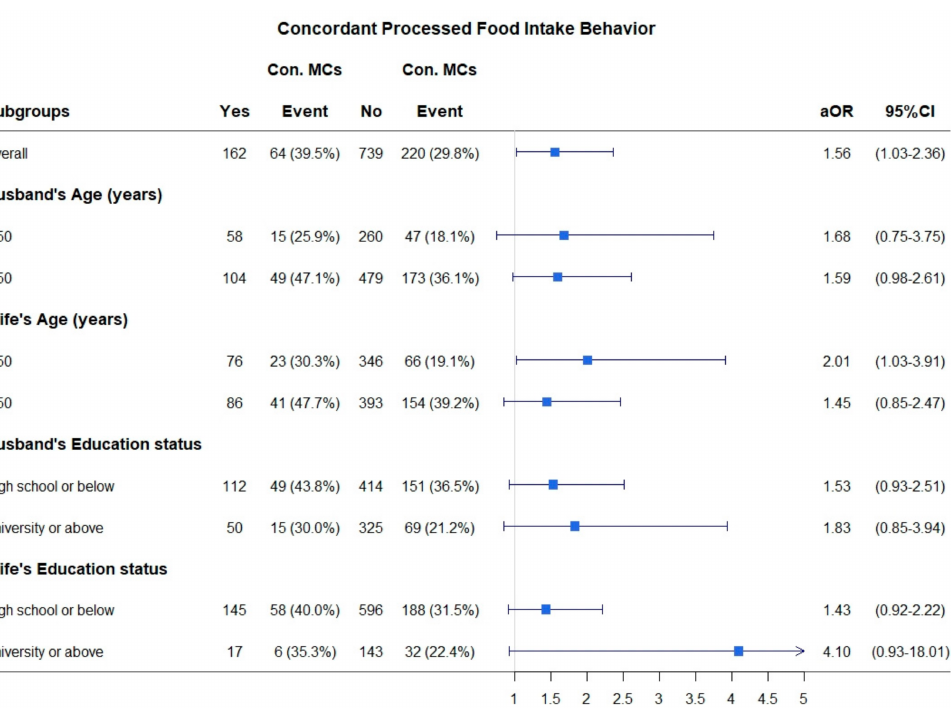
Figure 1. Stratified analysis for the association between concordant high-fiber food intake behavior and concordant composite MCs. Con. MCs: concordant composite metabolic components; (cid:4) : aOR: adjusted odds ratio; CI: confidence interval.